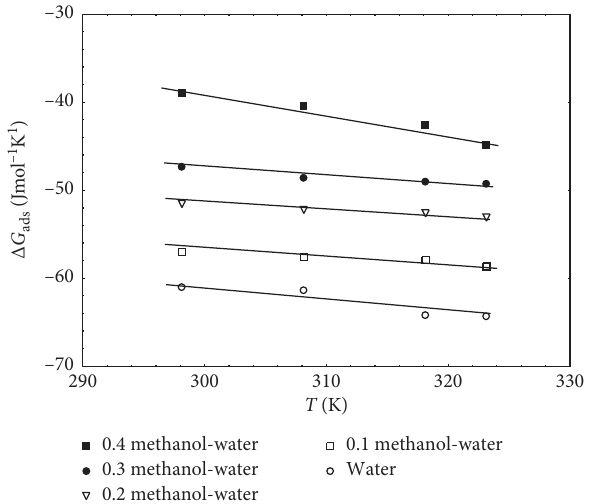
Figure 5: Variation in Δ G o of CTAB solution with temperature. ads